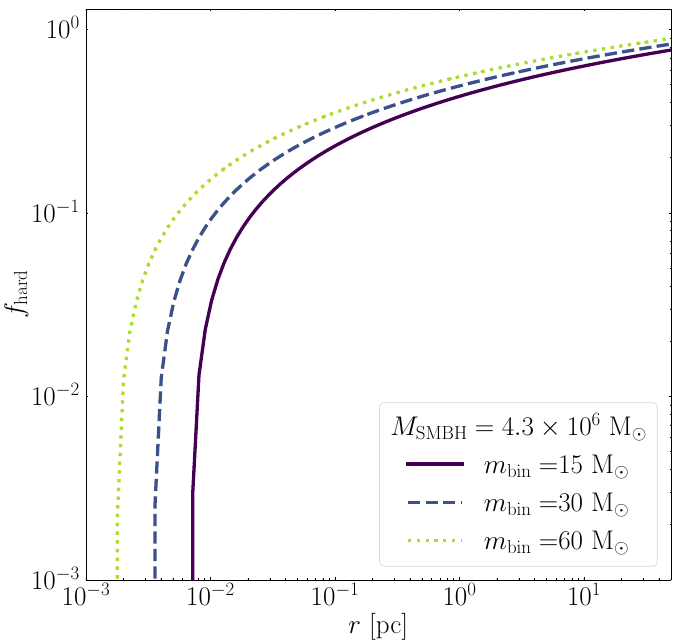
Figure 5. Fraction of hard binaries, normalised to the total population of binaries, as a function of the distance from an SMBH with mass M SMBH = 4.3 distribution flat in logarithmic values and limited between 10 − 2 –10 3